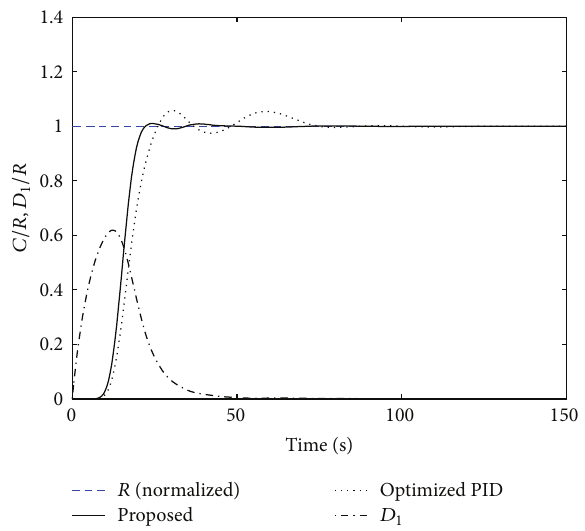
Figure 14: Normalized responses of 𝐶/𝑅 and 𝐷/𝑅 of Example 3.